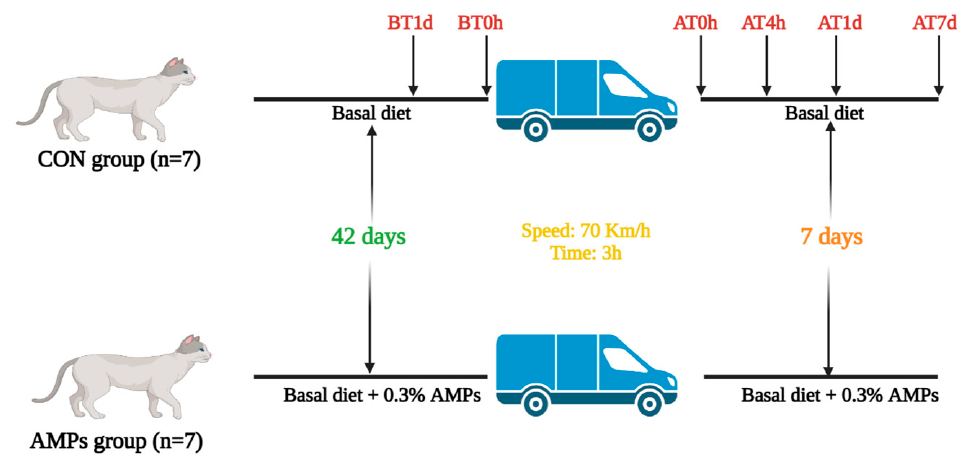
Figure 1. The sketch map of the study’s design. The CON group was fed a basal diet (n = 7), and the AMPs group was fed a basal diet with 0.3% AMPs (n = 7). BT1d, 1 day before transportation; BT0h, right before transportation; AT0h, right after transportation; AT4h, 4 h after transportation; AT1d, 1 day after transportation; AT7d, 7 days after transportation.